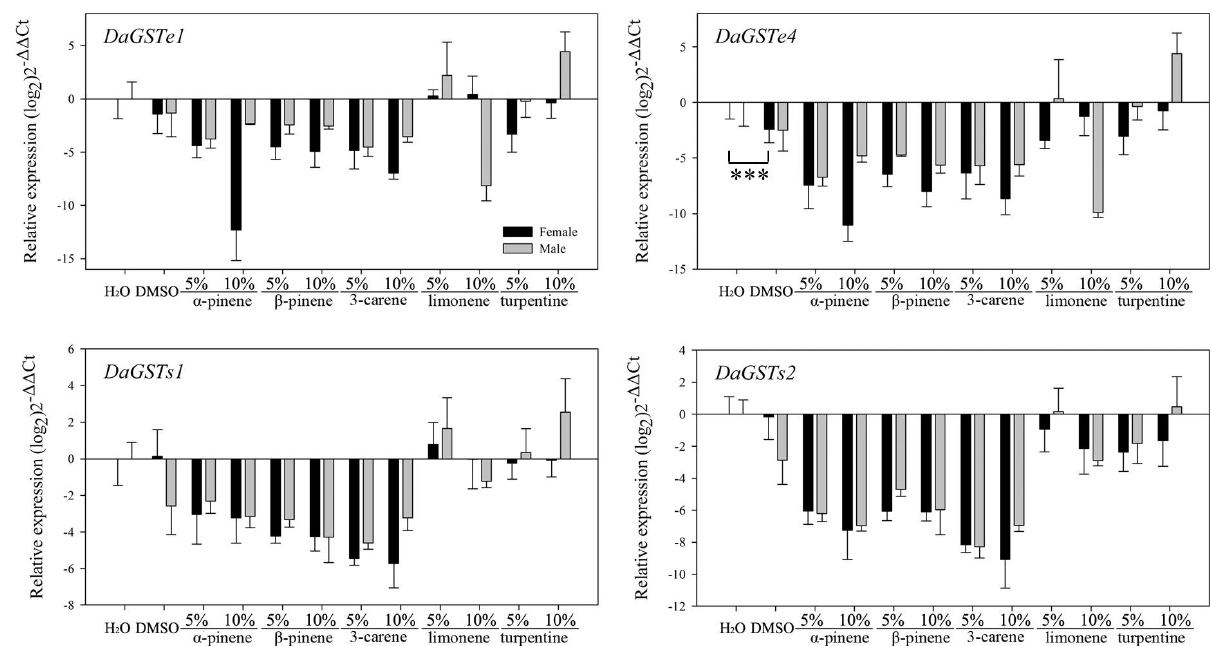
Figure 6. Realtime qPCR analysis of four GST genes relative expression (mean ± SE) in D. armandi after fed on pure artificial diet with stimuli at different concentrations for 24 h. Values > 1 on the logarithmic y-axis indicate upregulation. Gene expression was normalized with respect to the geometrical mean of β -actin and CYP4G55. Asterisks indicate significant differences between the blank control and the solvent control based on the independent sample t -test of each gene’s expression (*** p < 0.001). Statistically significant differences in gene expression among concentrations are shown in Table 3. The 2 − ∆∆ Ct and SE values were log 2 transformed for plotting.